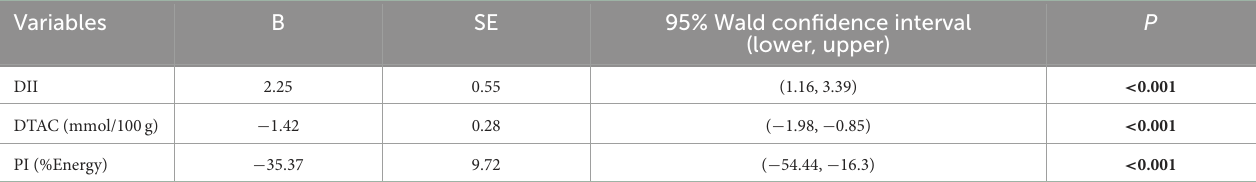
TABLE 4 Linear regression model using the GEE method for assessing the association of DII, DTAC, and PI with 8-OHdG in all participants. Variables